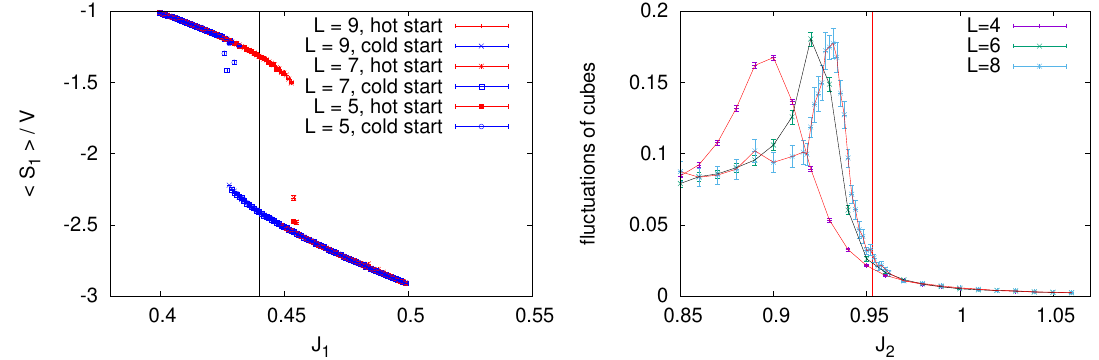
Figure 3 . Left: results for the action around J 1 phase transition. There is a region of J 1 couplings where the simulations starting from different initial configurations: cold or hot converge to different local, meta-stable states. Outside of that region, the action has only one minimum and both simulations give the same average value of the plaquette action. Right: evidence for a second order phase transition in the J coupling. Figure shows the fluctuations of the G observable for 2 simulations at different linear size extends ranging from L = 4 up to L = 8 . Data points shown are averages of independent simulations conducted in the Q = 1 and Q = − 1 topological sectors. The 0 0 maximum in the fluctuations approaches the theoretical, infinite limit value shown as the vertical line at J crit as discussed around (2.31). 2